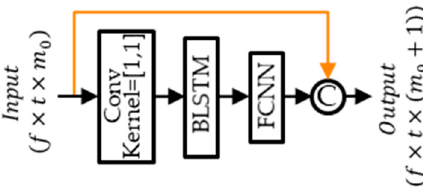
Figure 3. The architecture of LSTM block.